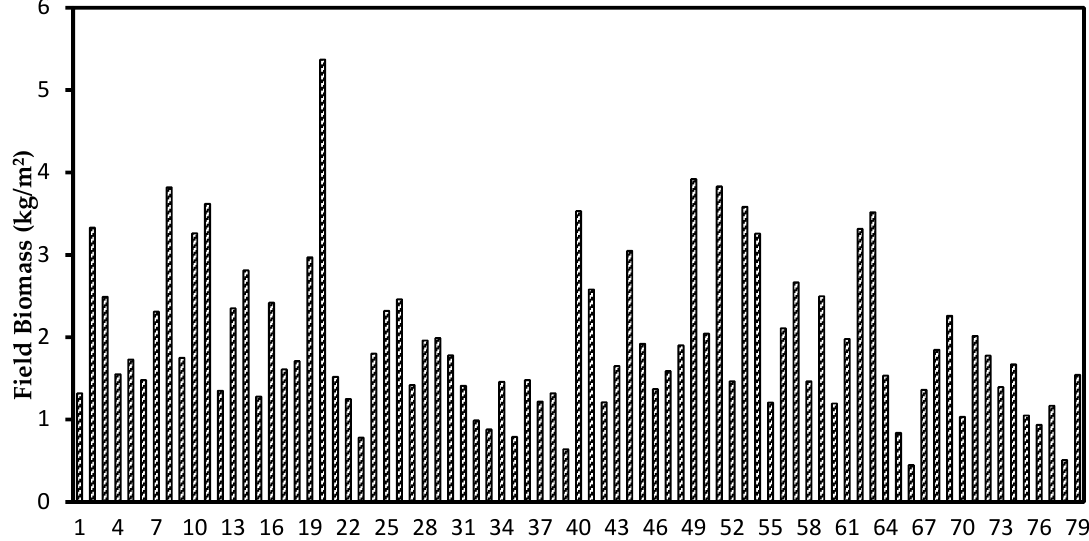
Figure 3. Field measurements of biomass at the GLAS footprint level.